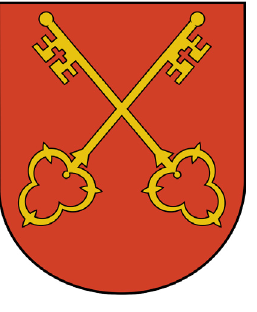
Figure 9. The former arms of